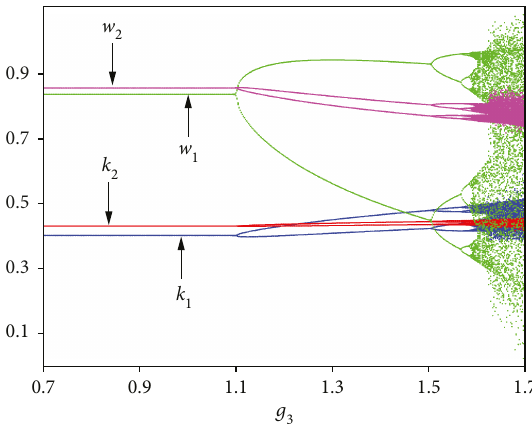
Figure 10: Bifurcation diagram of k 1 70